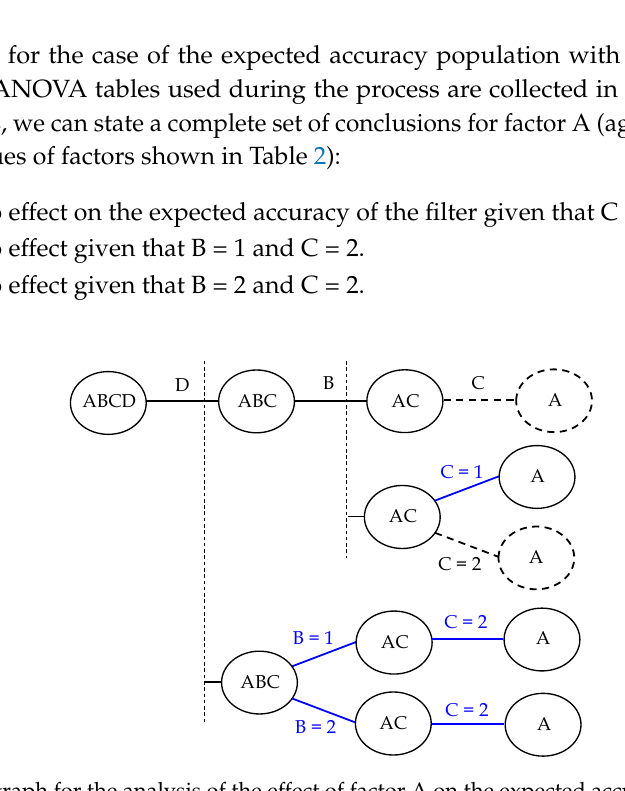
Figure A4. Tree graph for the analysis of the effect of factor A on the expected accuracy performance of the filter. Dashed nodes and arcs correspond to rejected conclusions due to multimodal populations. Arcs in blue denote decisions on the value of factors based on interactions that are forced by us to get unimodality in the data.